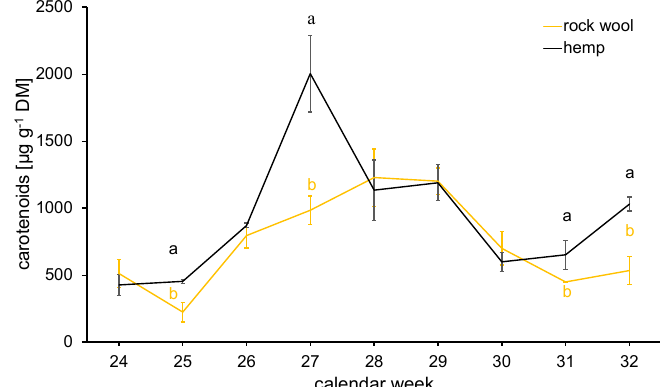
Figure 2. Influence of different substrates on the total carotenoid content in tomatoes. Different small letters indicate significance between variants ( t -test, p < 0.05, n = 3).